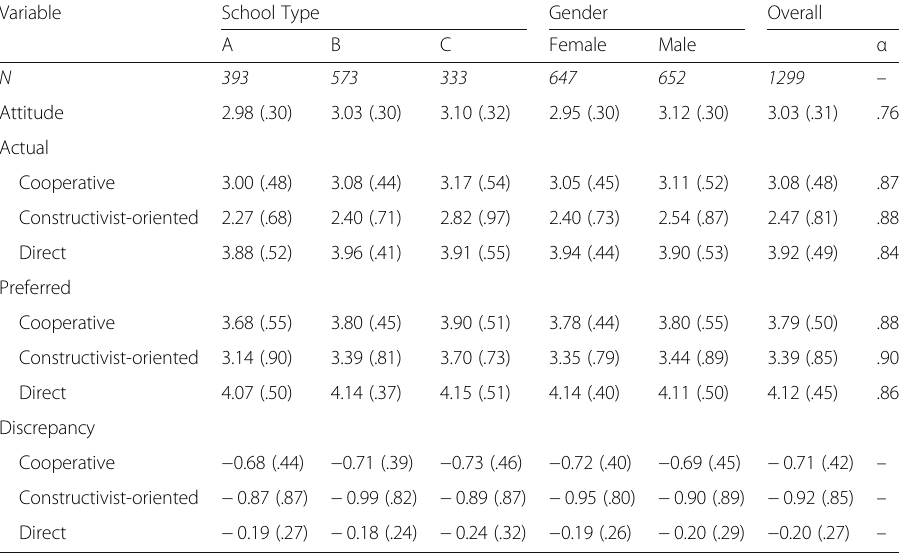
Table 3 Descriptive statistics for scales in the study ( N = 1299) Variable School Type